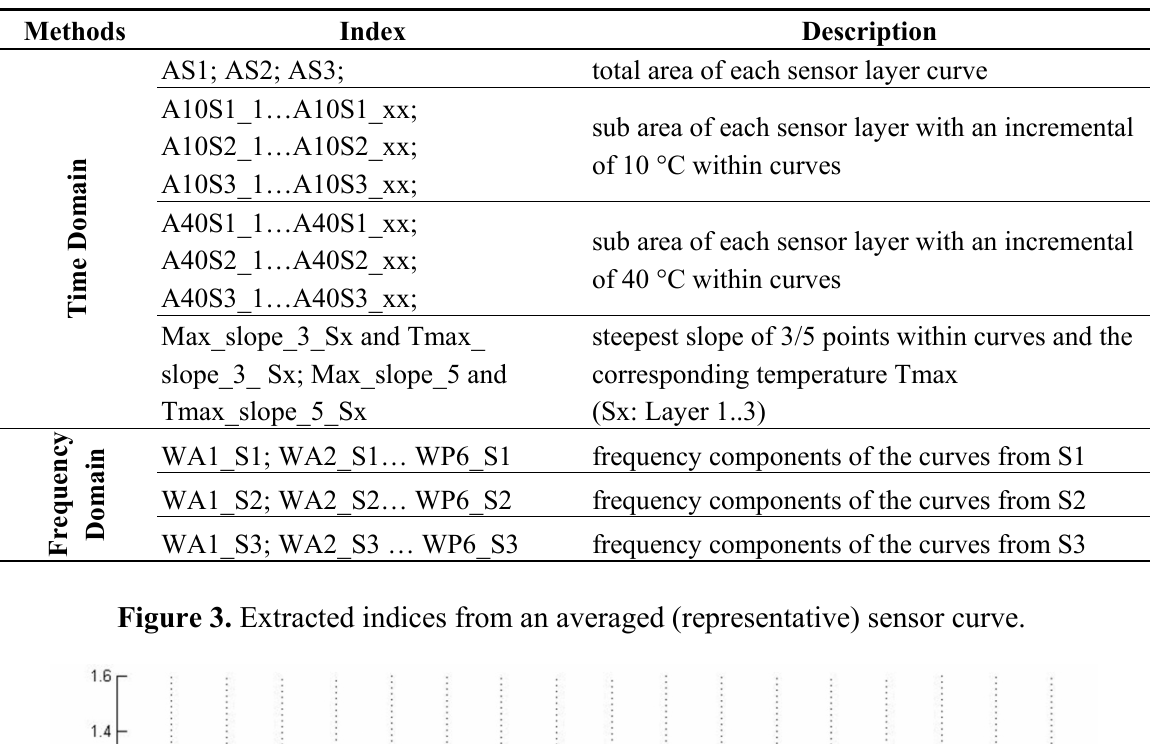
Table 1. Extracted indices from time- and frequency domains (S1—sensor layer1,